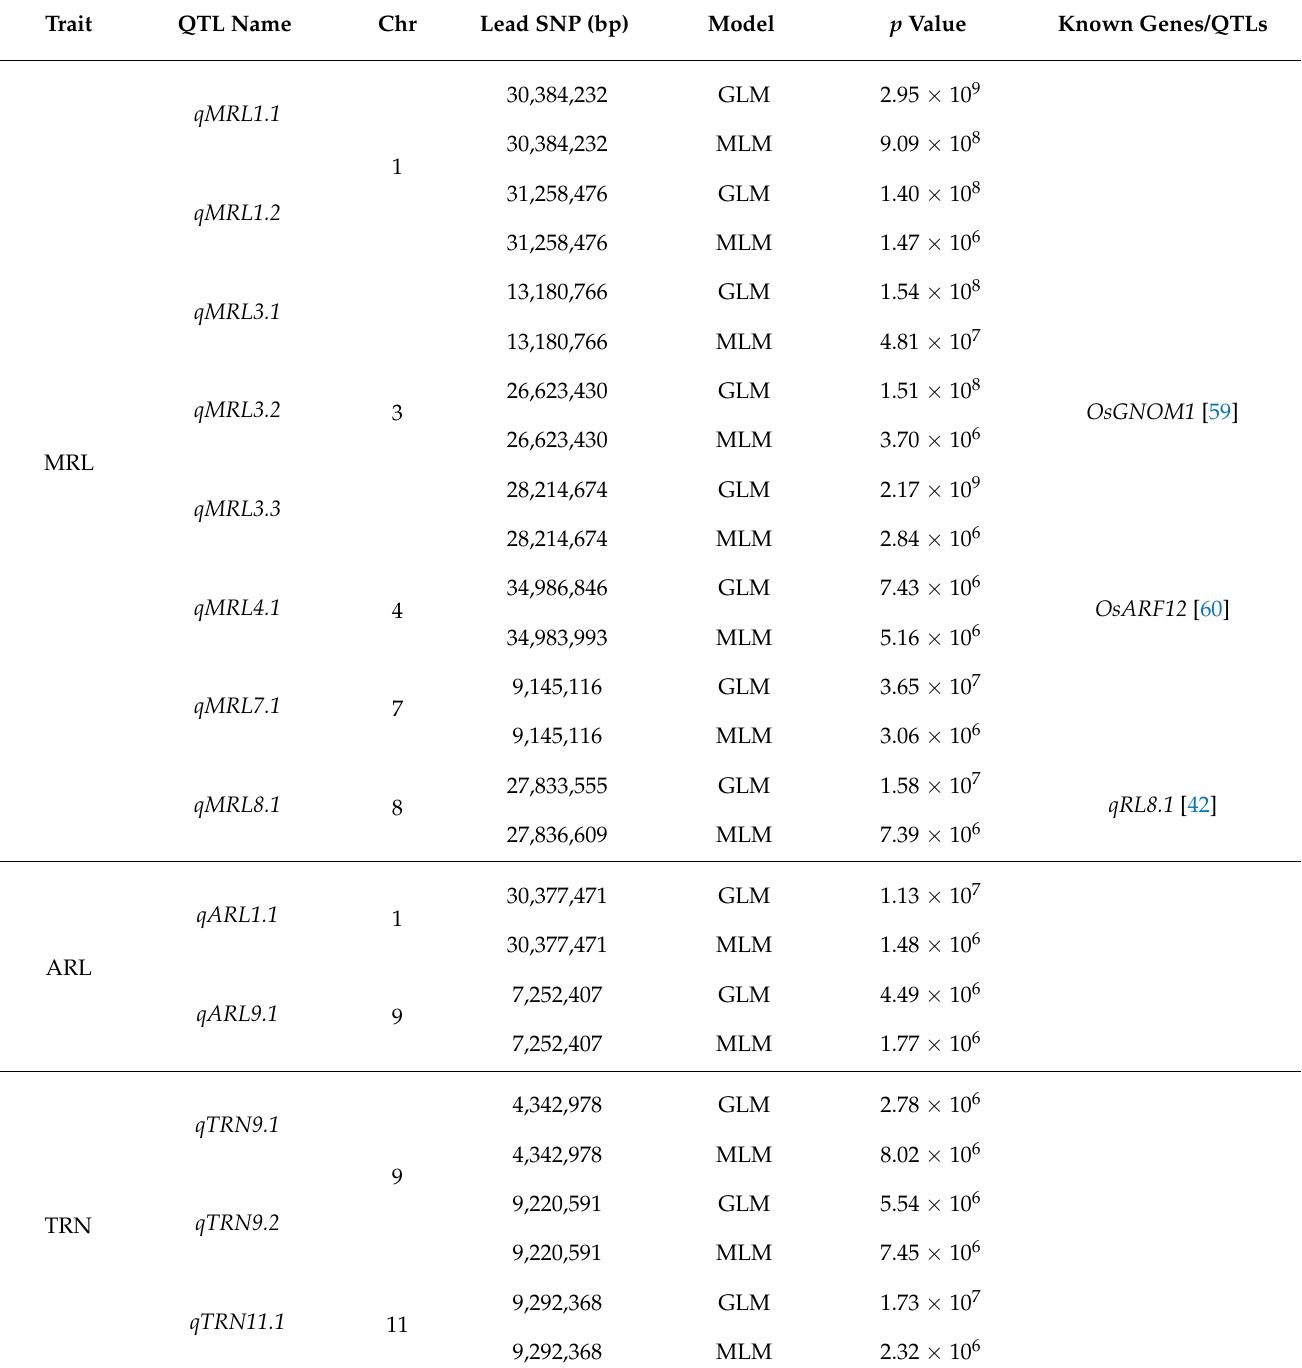
Table 2. Thirteen regions with significant signals related to MRL, ARL, and TRN in the genome-wide association study of 391 rice